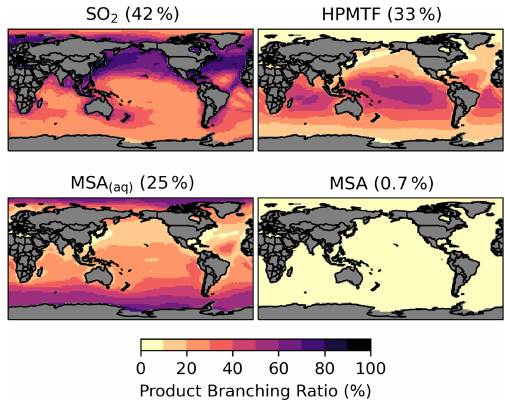
Figure 6. Branching ratio (percent) of the multiphase DMS oxi- dation pathways in [MOD_2000], considering HPMTF, SO 2 , and MSA as terminating products estimated from their annual total pro- duction